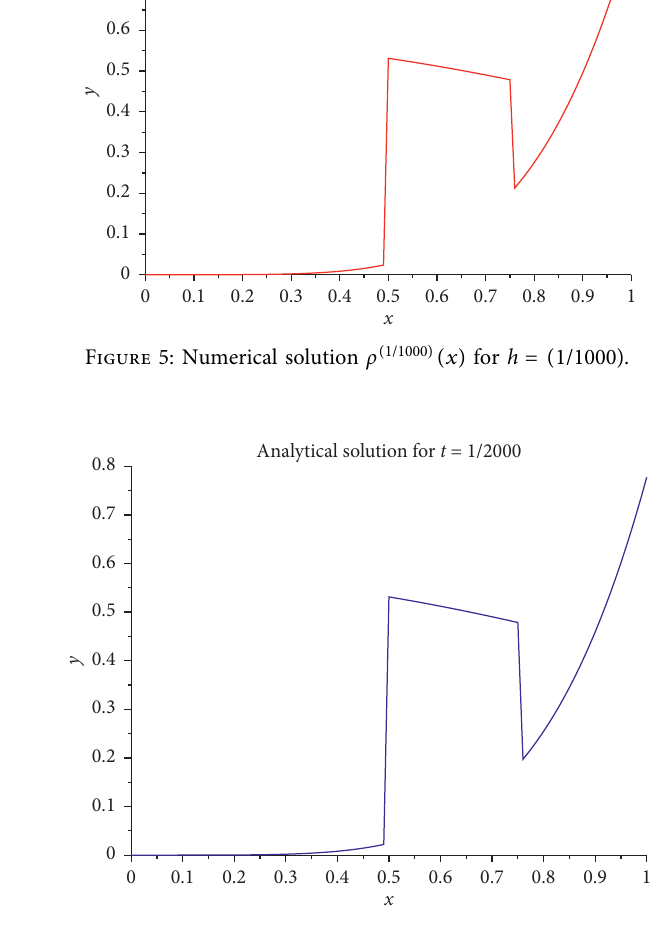
Figure 6: Analytical solution ρ (( 1/2000 ) , x ) for h � ( 1/1000 ) and t � ( 1/2000 ) ∈ ( 0 , ( 1/1000 )]